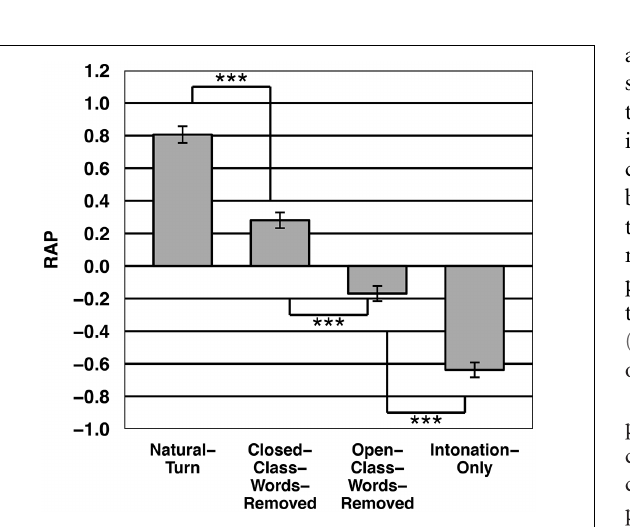
FIGURE 8 |Average RAP value per condition from Experiment 3. Asterisks indicate statistical significance at the 0.001